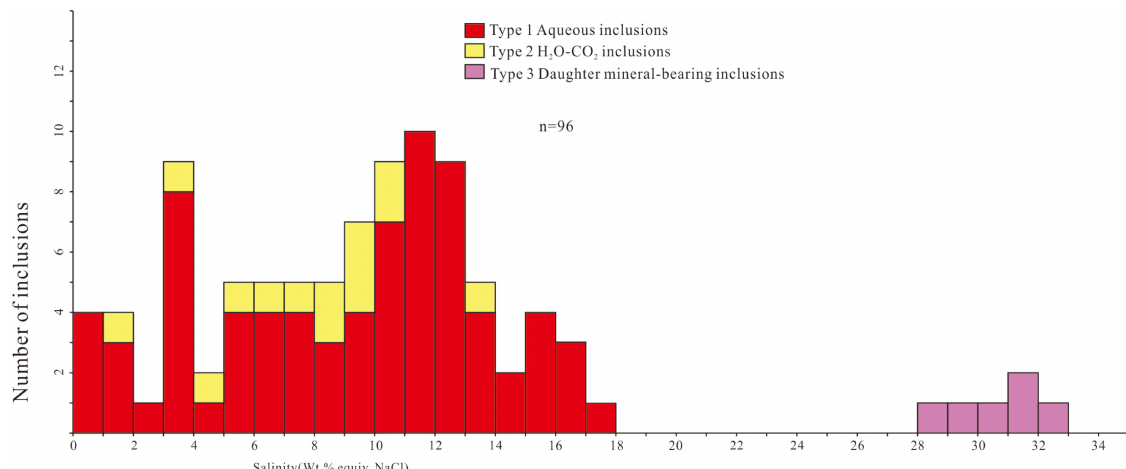
Figure 8. Frequency histograms of salinity (wt.% equiv. NaCl) of different types of fluid inclusions trapped in